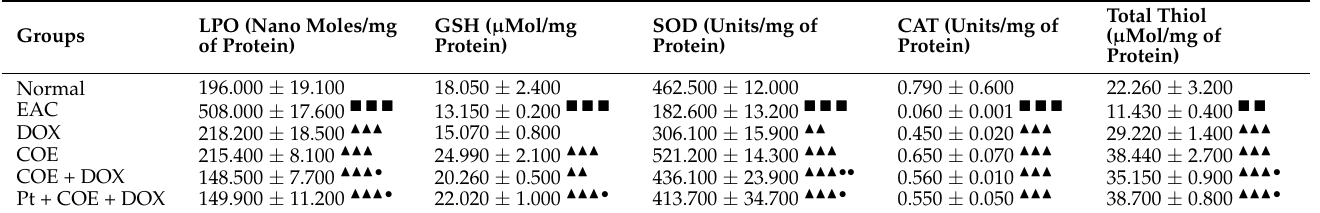
Table 7. Effect of COE on enzymatic and nonenzymatic antioxidant biomarkers in heart